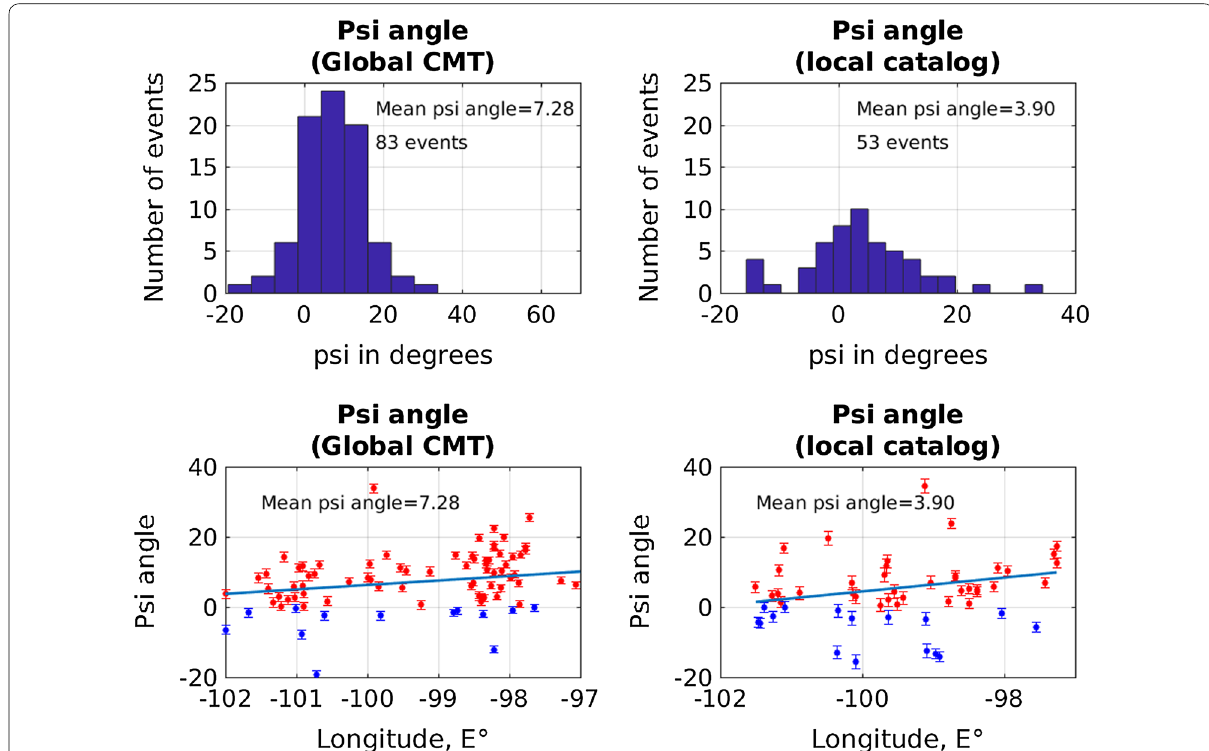
Fig. 6 ψ -angles. Histogram of ψ -angles and ψ -angles with respect to longitude, based on data from publications of Pacheco and Singh (2010), Yamamoto et al. (2013), Pacheco et al. (2005) and the catalog of the SSN (referred as local catalog), and from selected Global CMT solutions. Red circles are positive ψ -angles, blue circles—negative ψ